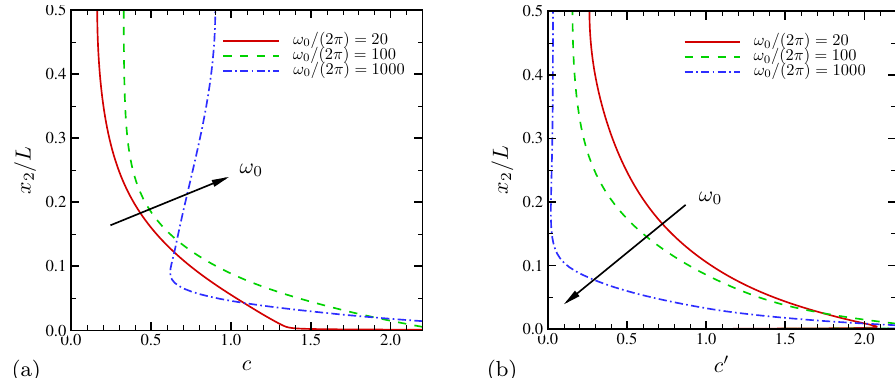
Figure 26. The wall-normal profiles of ( a ) time-averaged salt concentration and ( b ) salt fluctuation RMS. The diffusivity ratio is D − / D + =